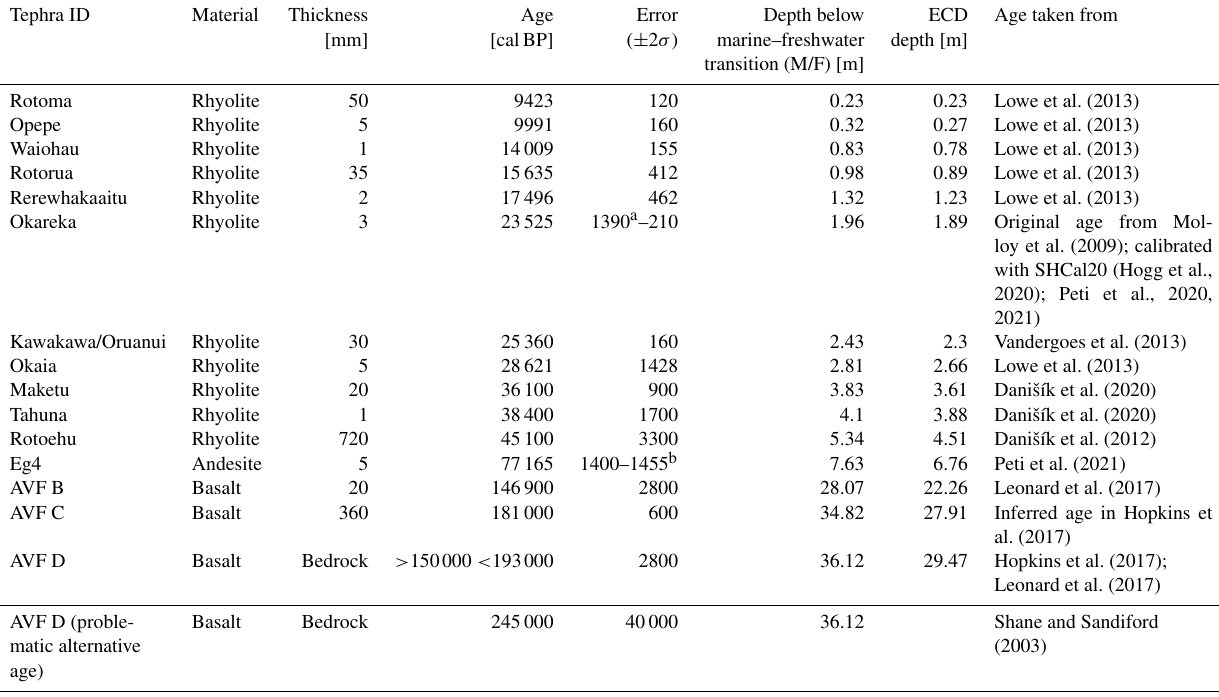
Table 2. Rhyolitic and andesitic tephra marker beds and basaltic deposits preserved in the Onepoto lake sediment record with assigned ages. ECD represents event-corrected depth.